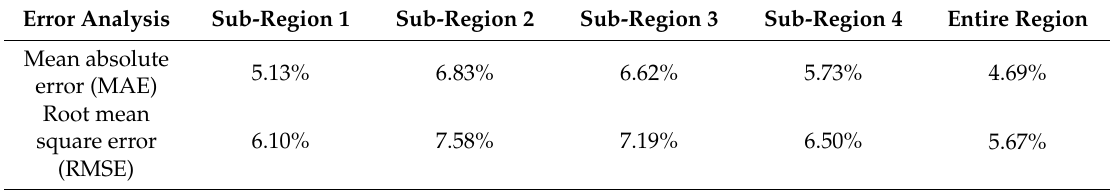
Table 2. Prediction error comparison of sub-regions and the entire